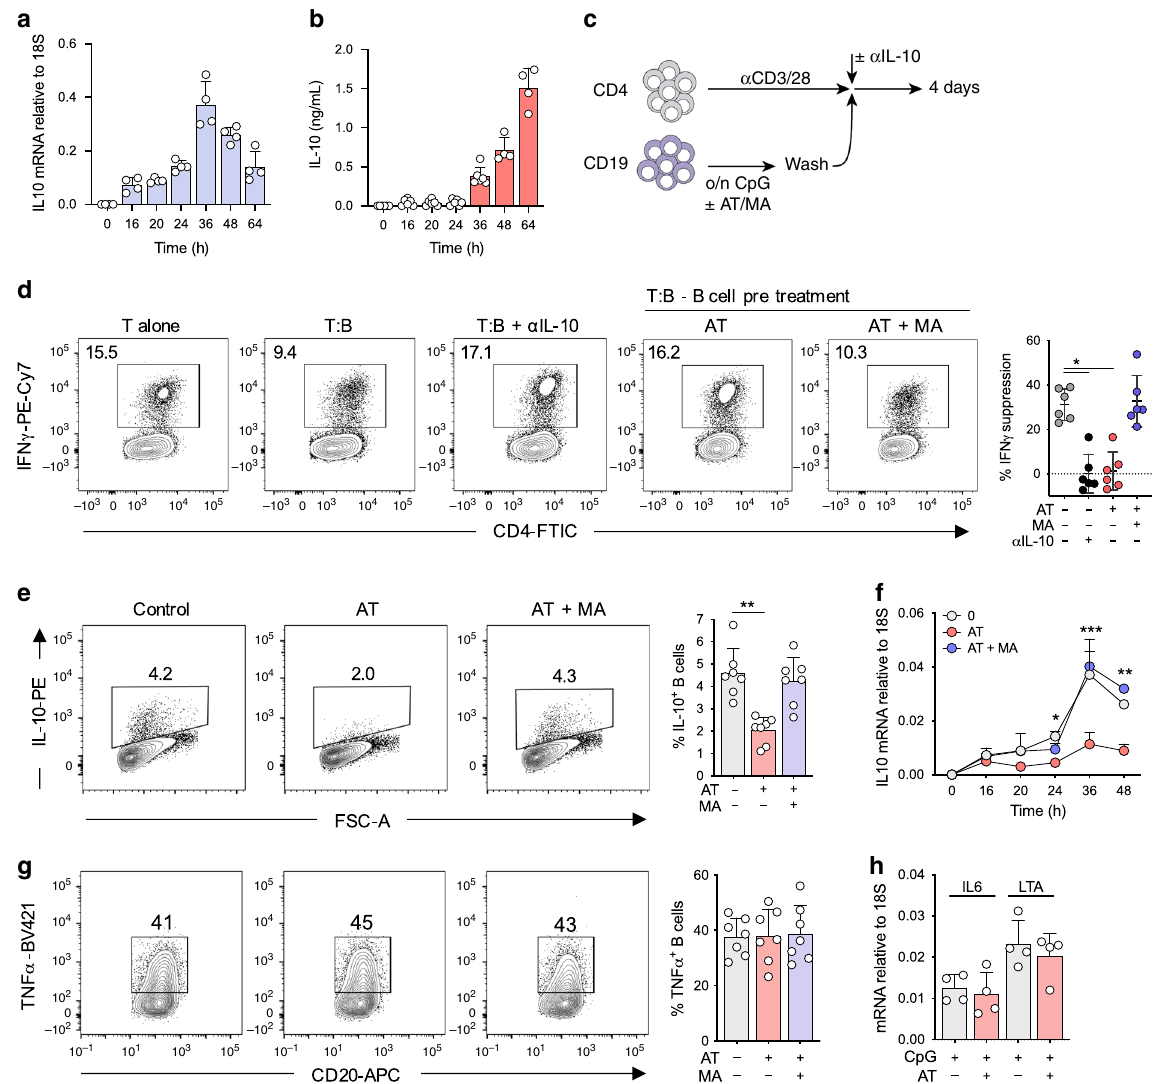
Fig. 1 Cholesterol metabolism drives regulatory B cell function. a , b Kinetics of IL10 mRNA transcript ( a ) and IL-10-secreted protein ( b ) expression at various time points in human B cells after TLR9 stimulation ( n = 4 for mRNA or n = 4 – 5 for protein). IL10 mRNA was measured by qRT-PCR, and calculated relative to 18S . c Schematic protocol for the co-culture for T and B cells. Brie fl y, human B cells were stimulated through TLR9±atorvastatin (AT)±mevalonate (MA) overnight, before washing and addition to anti-CD3/28 stimulated human CD4 + T cells for 4 days± α IL-10 antibody. d IFN γ production in human CD4 + T cells after co-culture with autologous TLR9-activated B cells ( n = 6, pval = 0.03 and 0.02). IFN γ suppression was calculated by (( x − y )/ x )*100 where x = IFN γ production by T cells alone, y = IFN γ production in co-cultured T cells. e IL-10 expression in human B cells after stimulation through TLR9±AT±MA ( n = 7, pval = 0.003). f IL-10 mRNA expression over time in human B cells after stimulation through TLR9±AT±MA ( n = 4). g TNF expression in human B cells after stimulation through TLR9±AT±MA ( n = 7). h IL6 or LTA mRNA expression, relative to 18S , in human B cells after stimulation through TLR9±AT ( n = 4). Each data point represents individual donors. All data presented are mean±SD. Statistical testing in all fi gures was done by a Friedman ’ s test with Dunns ’ s multiple comparisons test, or for ( f ) a mixed-effects model with Dunnett ’ s multiple comparisons test. * P <0.05, ** P <0.01, *** P <0.001, and all signi fi cant values are GGTase, but not FTase, substantially reduced TLR9-induced IL- pathways implicated in immune function including mevalonate, 10 production, indicating that geranylgeranyl dependent mod- isoprenyl and sterol metabolism (Supplementary Fig. 1), all of i fi cations regulate IL-10 expression (Fig. 2b, Supplementary which are attenuated by HMG-CoA reductase inhibition to Fig. 5a, b). In keeping with the effects of HMG-CoA reductase varying degrees. Given that defects in the isoprenyl branch have inhibition, in fl ammatory cytokine production was preserved been demonstrated to result in hyperin fl ammatory responses (Fig. 2c). Furthermore, we observed no or little effect on the in vivo 23,26 , we investigated if isoprenylation was regulating IL- 10. To this end, we targeted geranylgeranyltransferase (GGTase) proliferation, differentiation, and antibody production by B cells and farnesyltransferase (FTase), enzymes known to post- after TLR9 ligation in the presence of either atorvastatin or GGTi translationally modify proteins with geranylgeranyl pyropho- during longer cultures (5 – 7 days, Supplementary Fig. 5c). In sphate (GGPP) or farnesyl pyrophosphate (FPP) groups respec- experiments to test GGTase speci fi city, we also observed that IL- tively (enzymes and metabolites outlined in Fig. 2a). Inhibition of 10 was dependent on GGTase-I, but not GGTase-II, as inhibition